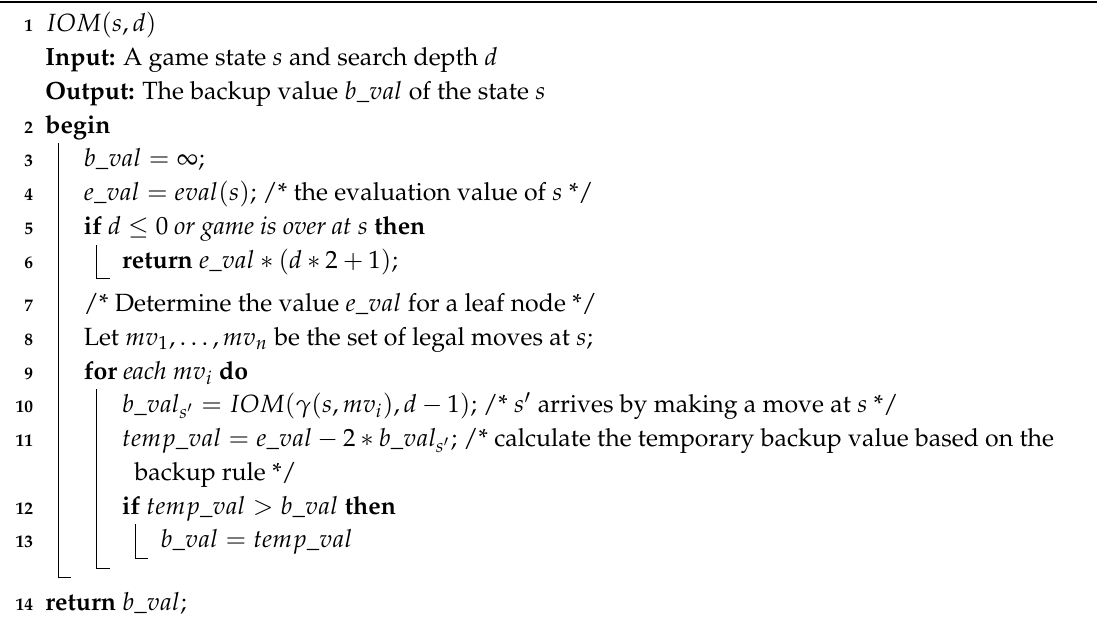
Algorithm 1: Iterative optimal minimax